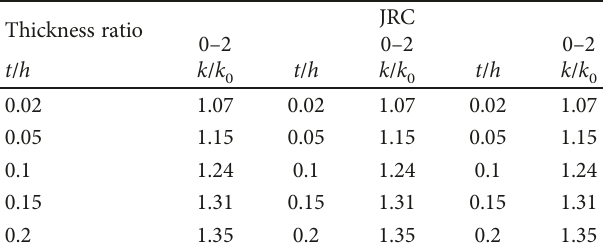
Table 4: E ff ect of thickness ratio ( t/h ) and the joint roughness coe ffi cient (JRC) on yield